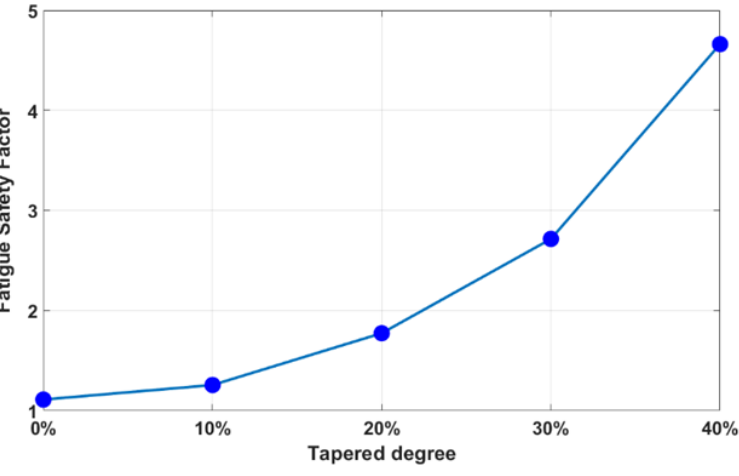
Figure 11. Fatigue safety factor as a function of the strut-tapered degree.